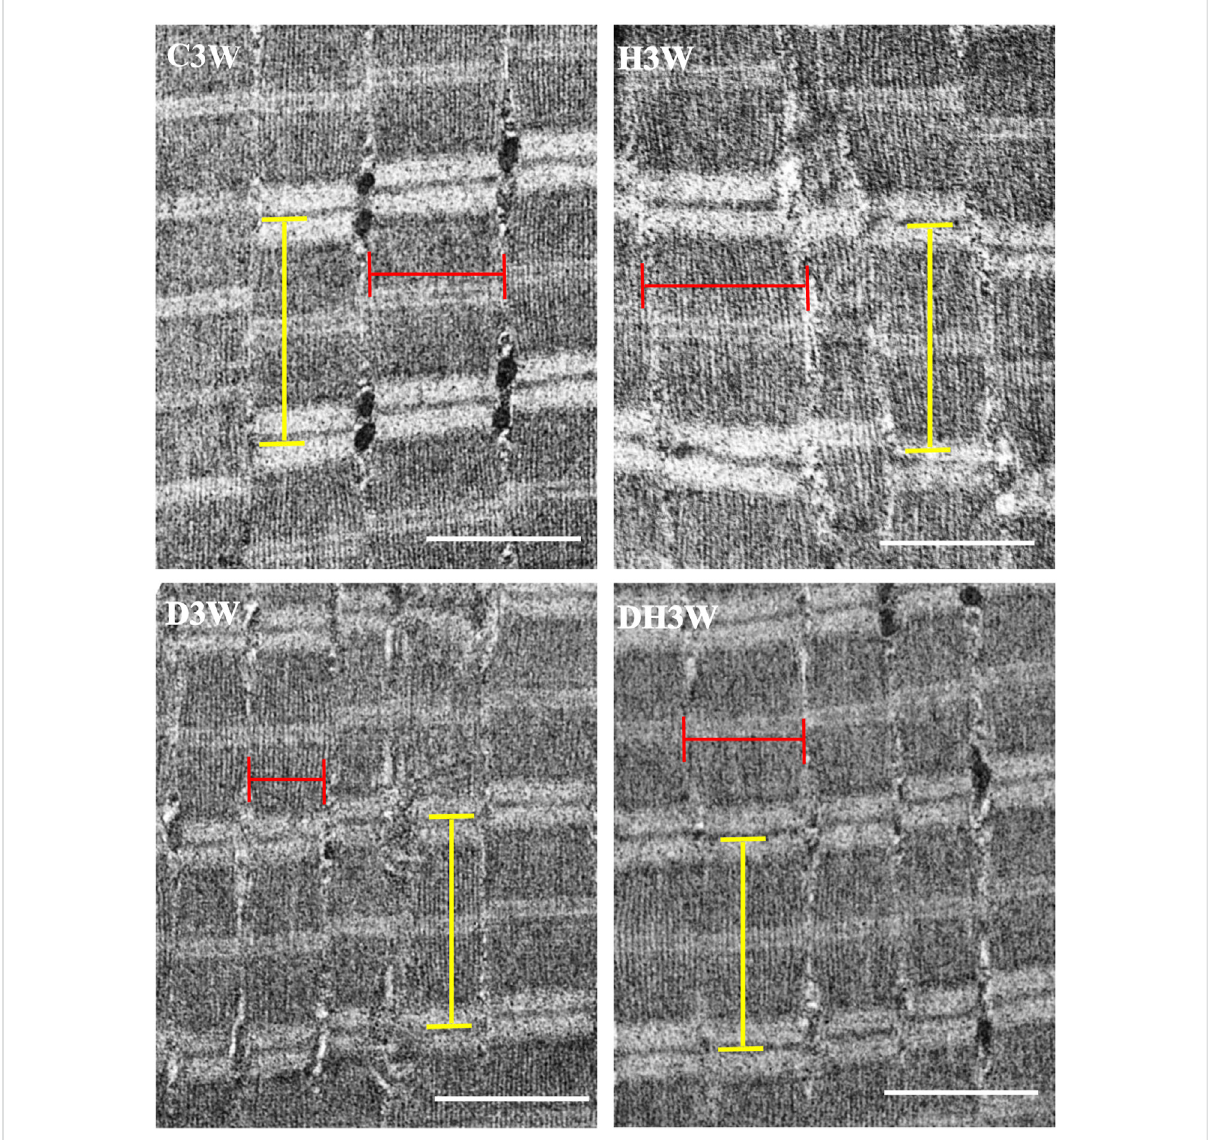
FIGURE 5 Representative electron photomicrographs of longitudinal sections muscle fi bers in different groups in a short term experiment. Note the decreased muscle fi bril size (indicated by the red line) in D3W compared to C3W. The muscle fi bril size was increased in size in DH3W compared to D3W. However, it is thinner than that in C3W and H3W groups. The dimension of the sarcomere (indicated by the yellow line) was similar when compared between groups. Scale bar = 1000